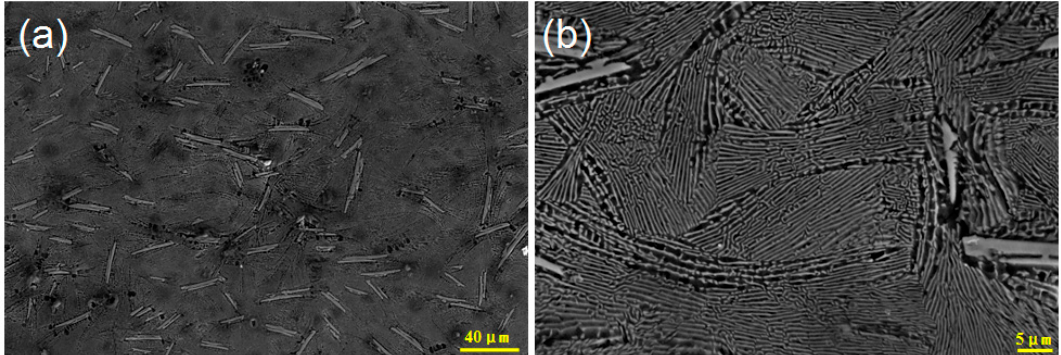
Figure 4. ( a ) Microstructure of Mg–31Ni alloy (designated as alloy D), and ( b ) the morphology of the eutectic region.